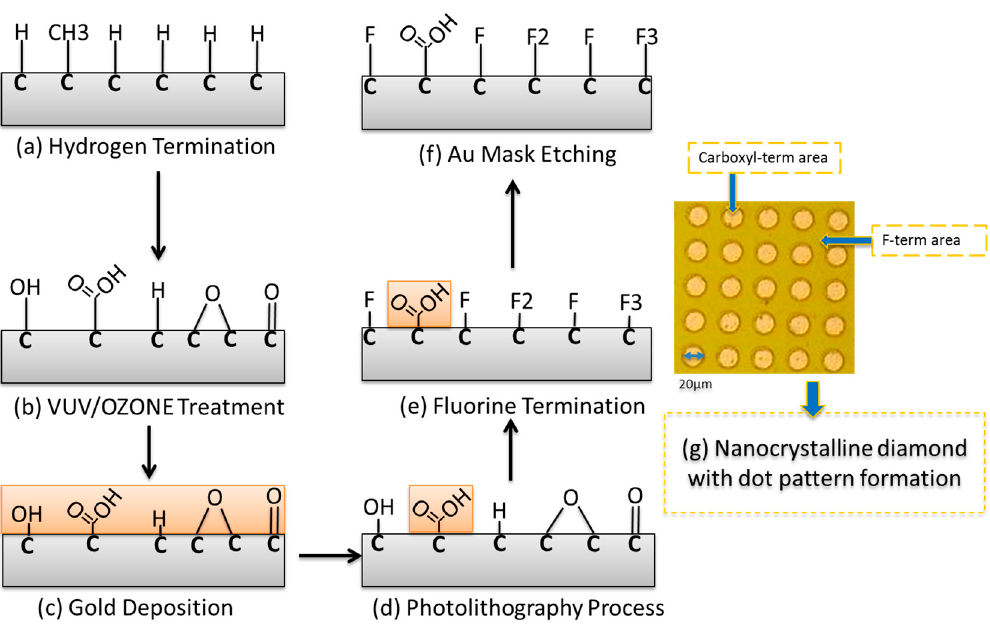
Figure 1. Schematic diagram of micropattern fabrication on the nanocrystalline diamond (NCD) surface. ( a ) Hydrogen termination; ( b ) Vacuum ultraviolet (VUV)/Ozone treatment; ( c ) Gold deposition; ( d ) Photolithography process; ( e ) Fluorine termination; ( f ) Au mask etching; ( g ) Optical microscopy image of the dot pattern formed on the NCD surface. The dots are terminated by carboxyl groups and regions outside the dots are fluorine-terminated as a background.